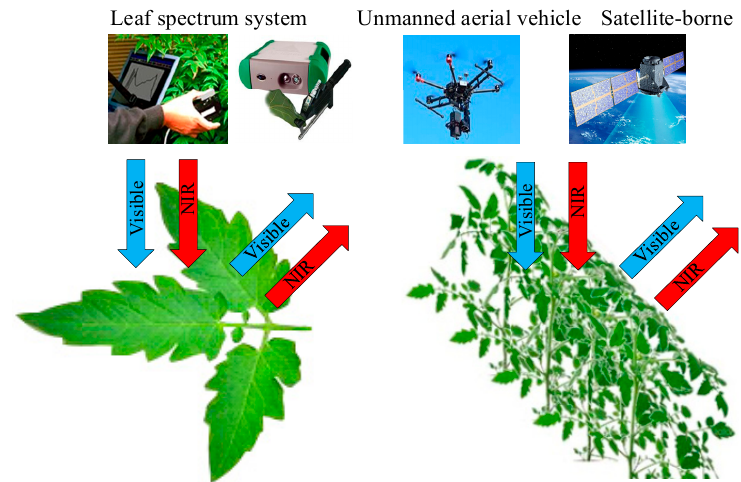
Figure 3. Basic principles of spectral technology.